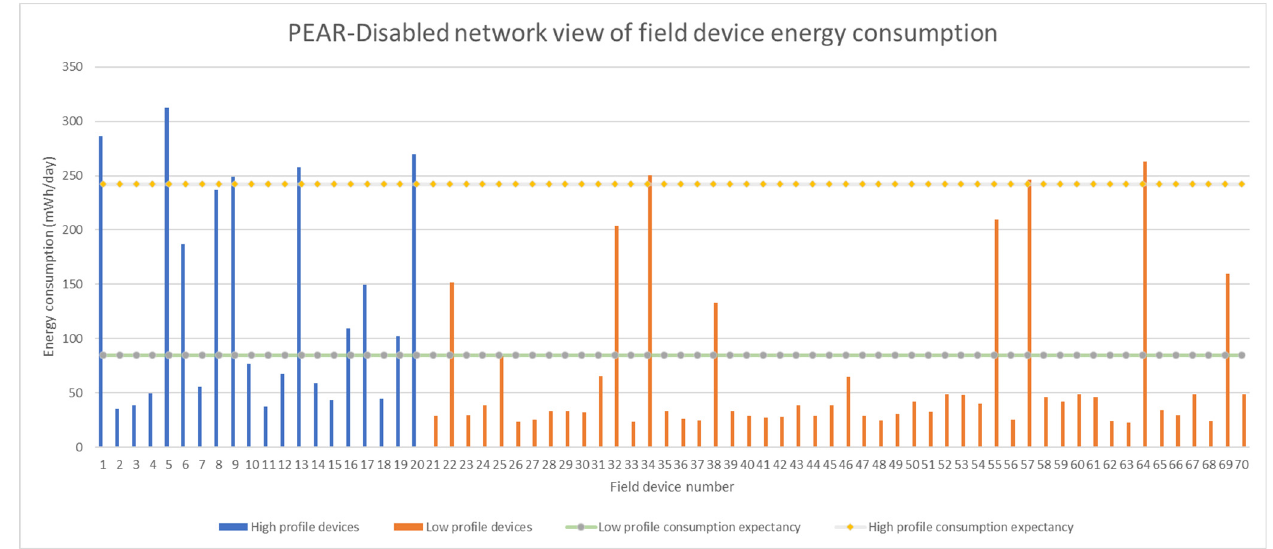
Figure 10. Average field device energy consumption for all devices in the network differentiated by the energy profile when PEAR is enabled.